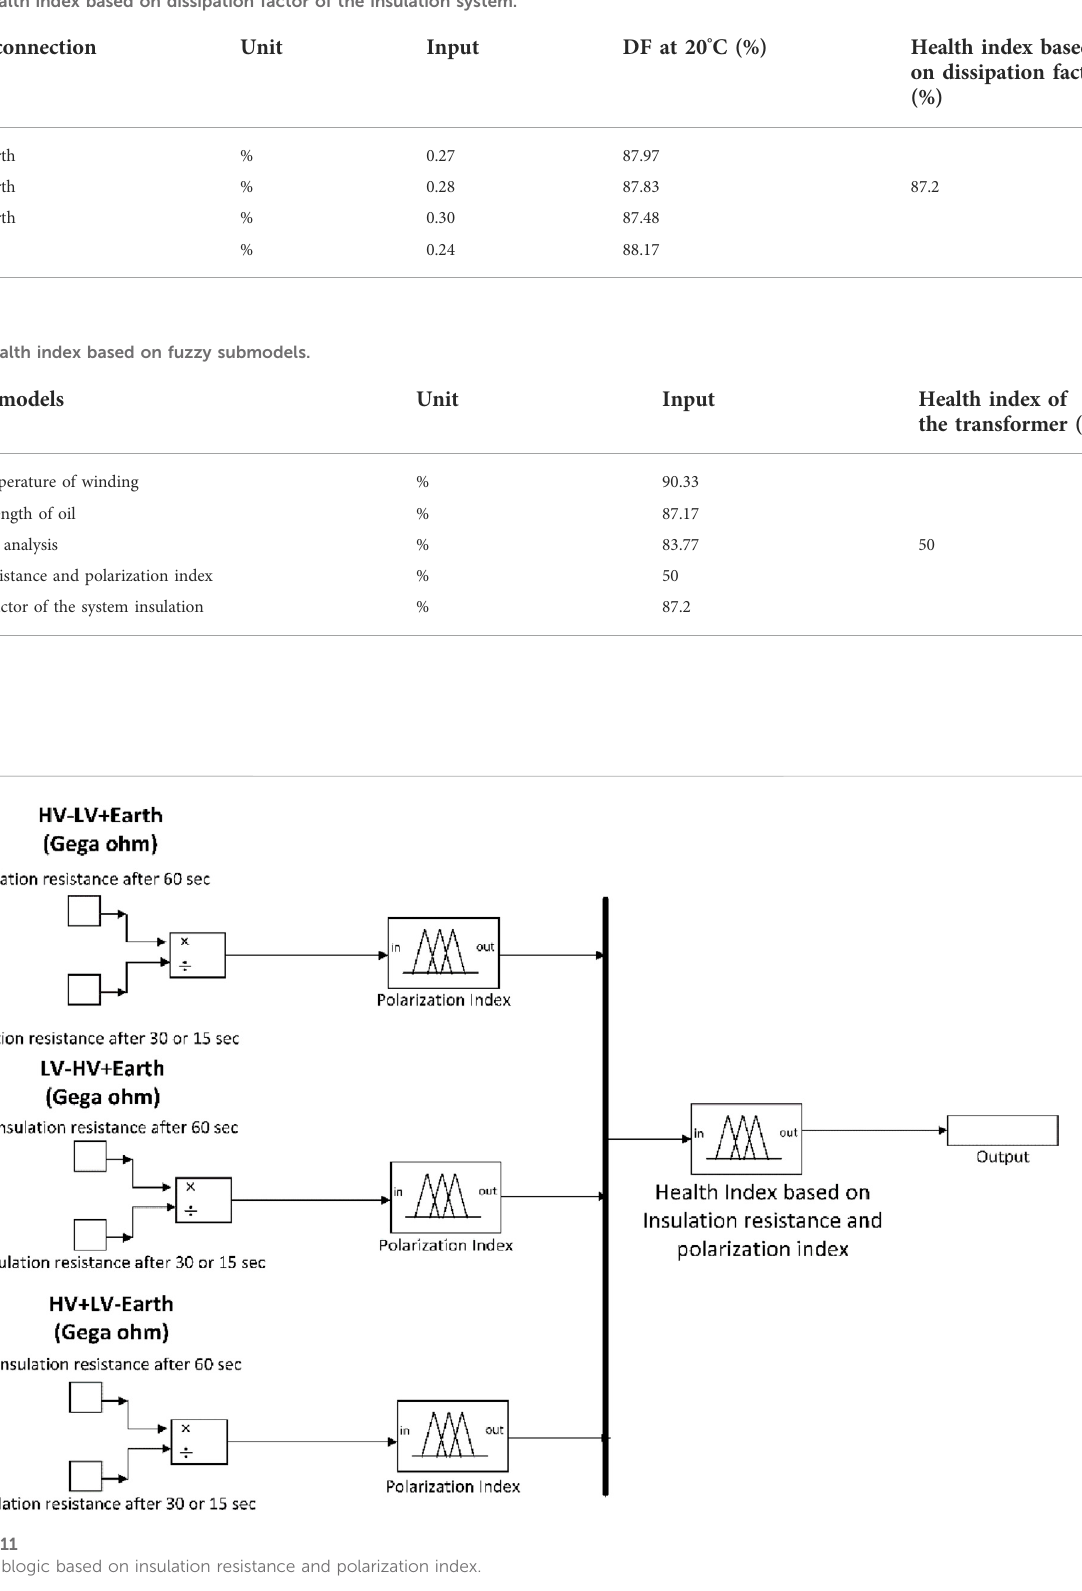
TABLE 7 Health index based on dissipation factor of the insulation system.